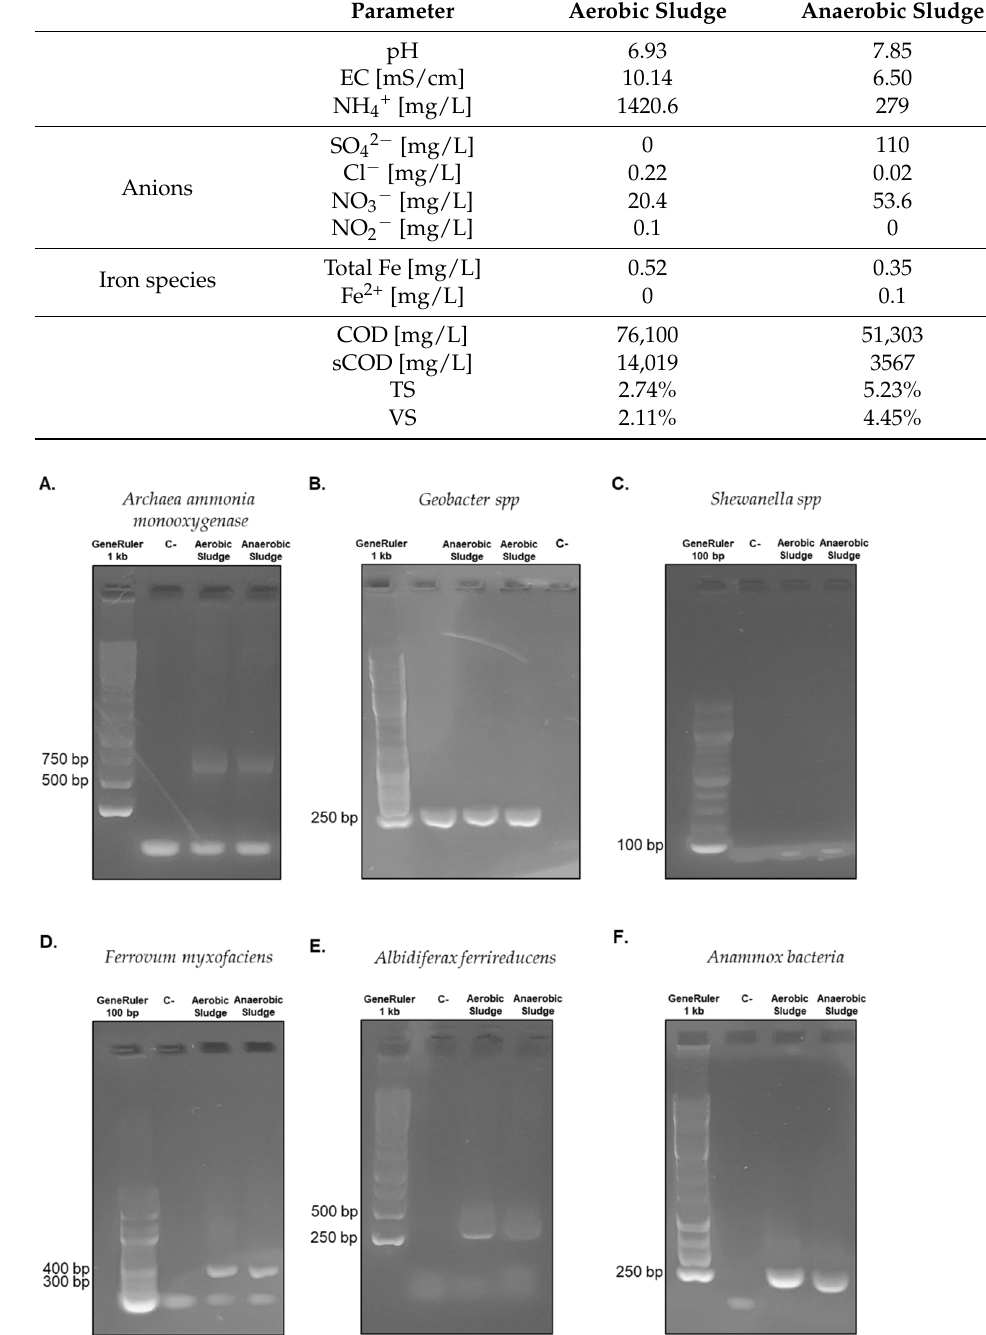
Figure 3. Electrophoresis gels PCR products to check for the presence of relevant Feammox genes. ( A ). amoAF